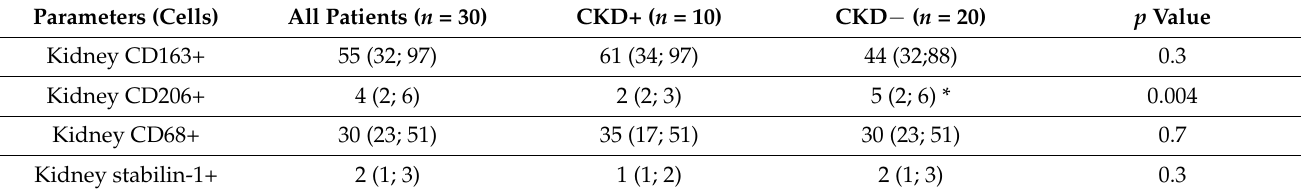
Table 3. Features of macrophages diversity in the kidneys in patients ( n = 30) with fatal myocardial infarction (MI), depending on the presence of chronic kidney disease (CKD) in